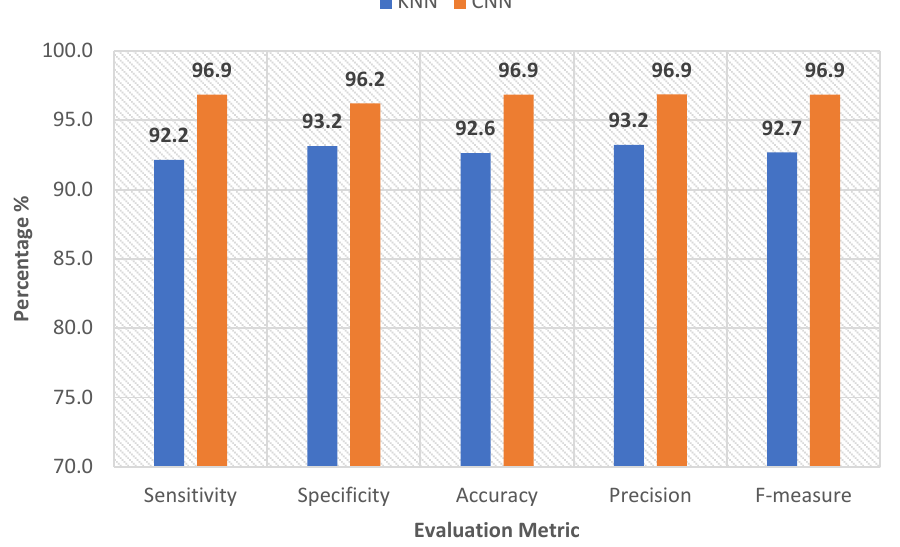
Figure 7. Evaluation metrics of the CNN and k NN classifiers (right side).